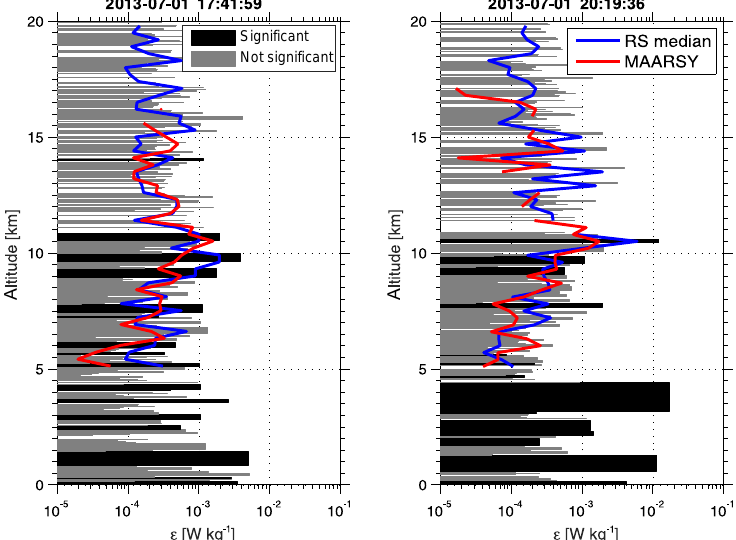
Figure 5. Vertical profiles of the derived dissipation rates from radiosondes (significant layers in black and non-significant layers in grey) with the median profile (in blue) and from radar (in red). Here all turbulent layers, including both significant and non-significant ones, from radiosondes were calculated as median for the comparison with the radar results. Please note the different height resolution of both instruments: 5m for radiosondes and 300m for radar. In order to compare the radar and radiosonde values one-to-one, we infer the median of radiosonde ε over 300m consistent with the height resolution of radar measurements, and they are shown in blue. The radar ε is calculated as the median for the period of 2h, straddling the time of the radiosonde ascent (two flights on 1 July